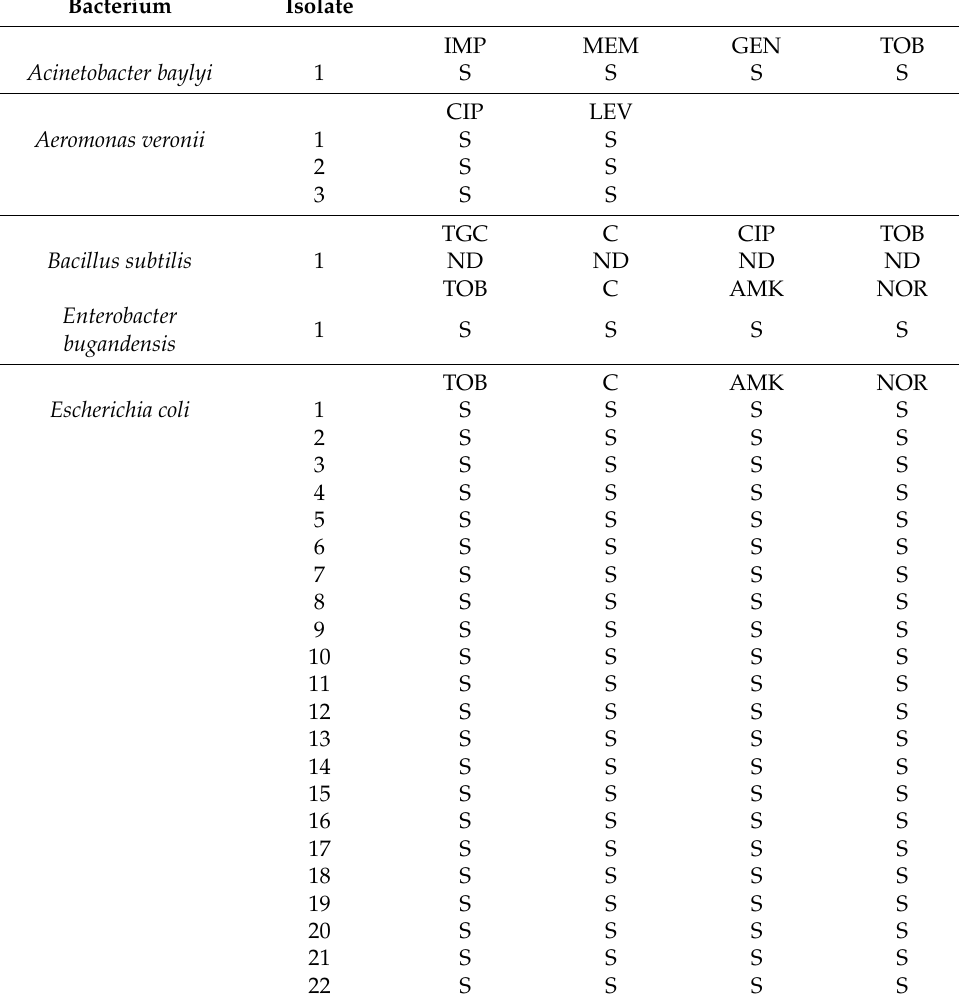
Table 3. Resistance profiles of bacteria recovered from ram semen samples.